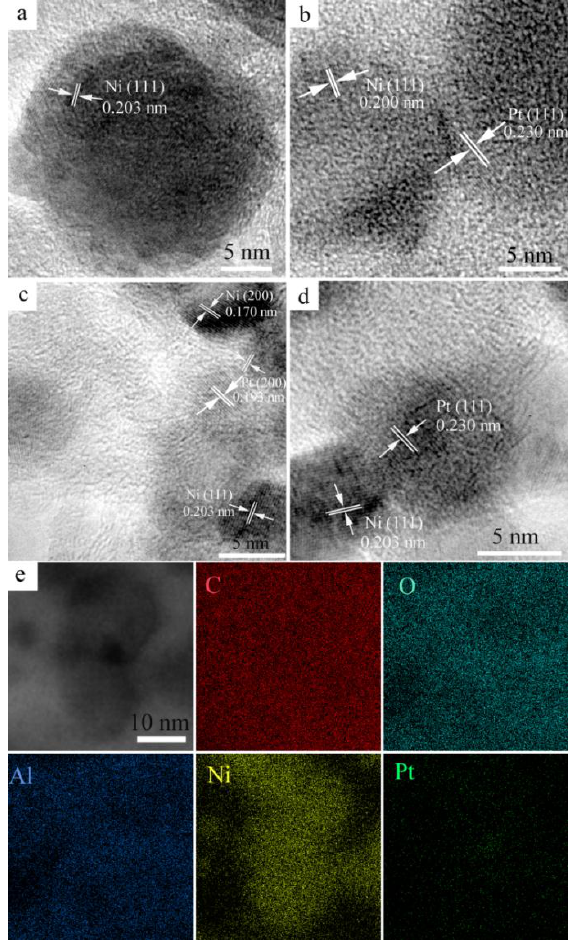
Figure 3. High-resolution transmission electron microscopy (HRTEM) images of the supported catalysts: ( a ) Ni; ( b ) NiPt-0.2%; ( c ) NiPt-0.6%; ( d ) NiPt-1.0%; ( e ) Energy dispersive X-ray spectroscopy (EDS) mapping of the catalyst NiPt-0.6%. Table 2. XPS binding energy of the Ni, Pt and Al core levels in the supported catalysts.